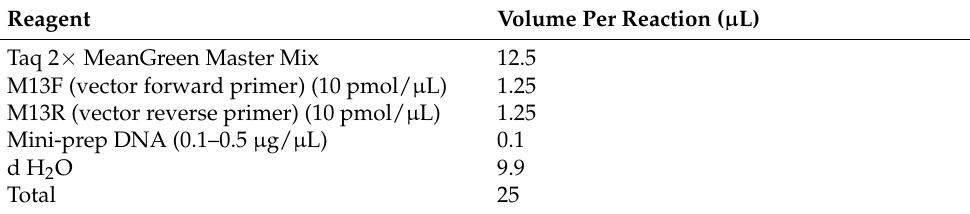
Table 9. Reaction mix for PCR amplification of the cloned insert. Reagent